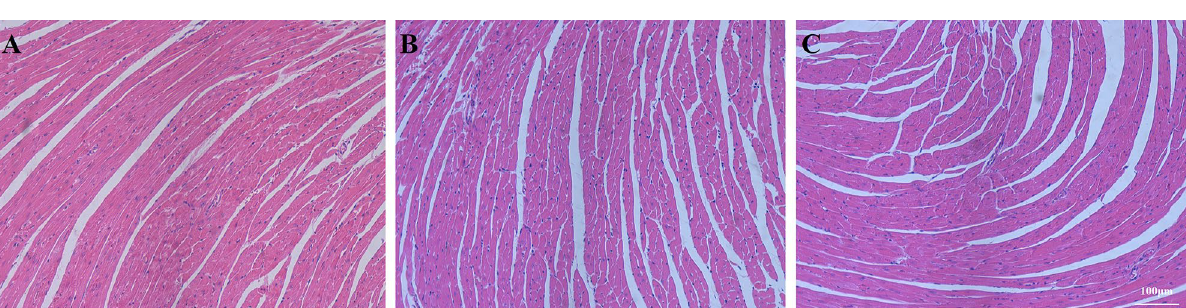
Figure 12. BM-MSCs improved LPS-induced heart injury at 48 h after LPS treatment. ( A ) Sham group. ( B ) LPS group. ( C ) LPS + MSC group. ( A – C , ×100